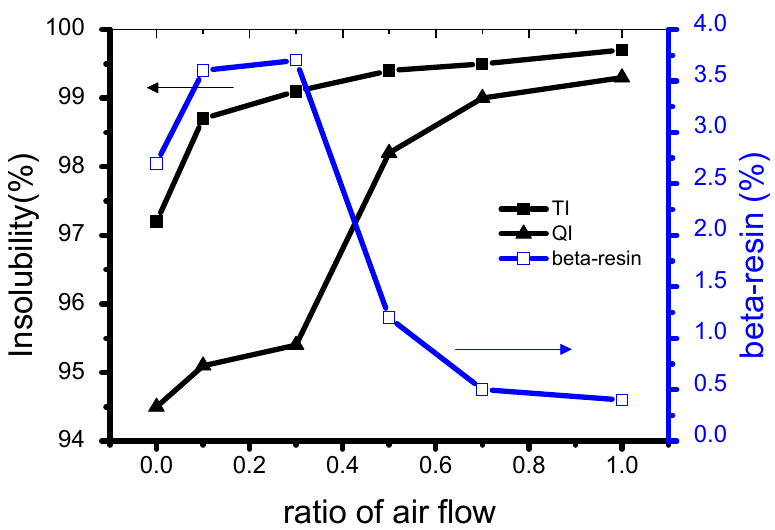
Figure 4. β -resin change in binderless cokes manufactured according to flow ratio of nitrogen and air.